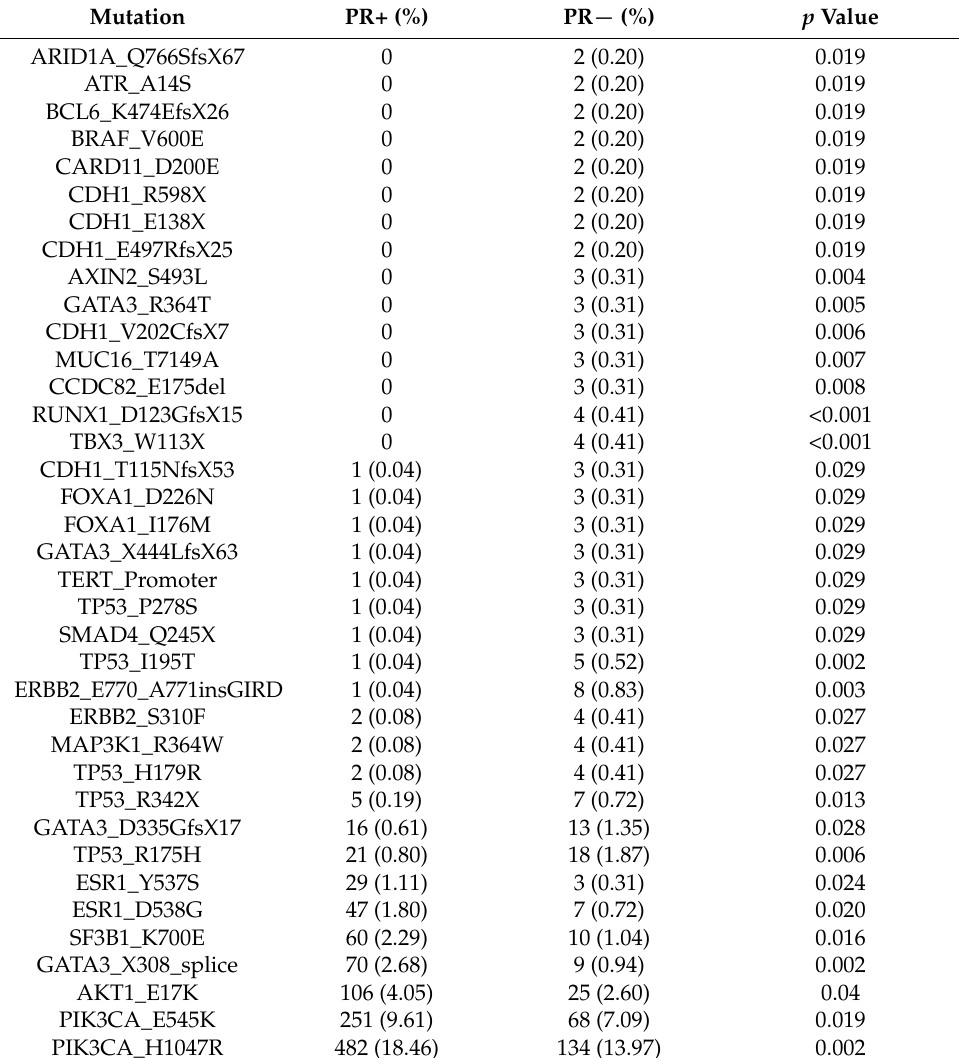
Table 2. The 37 recurrent mutations showing significant differences between ER+/PR − and ER+/PR+ breast cancers according to the test of Equal or Given